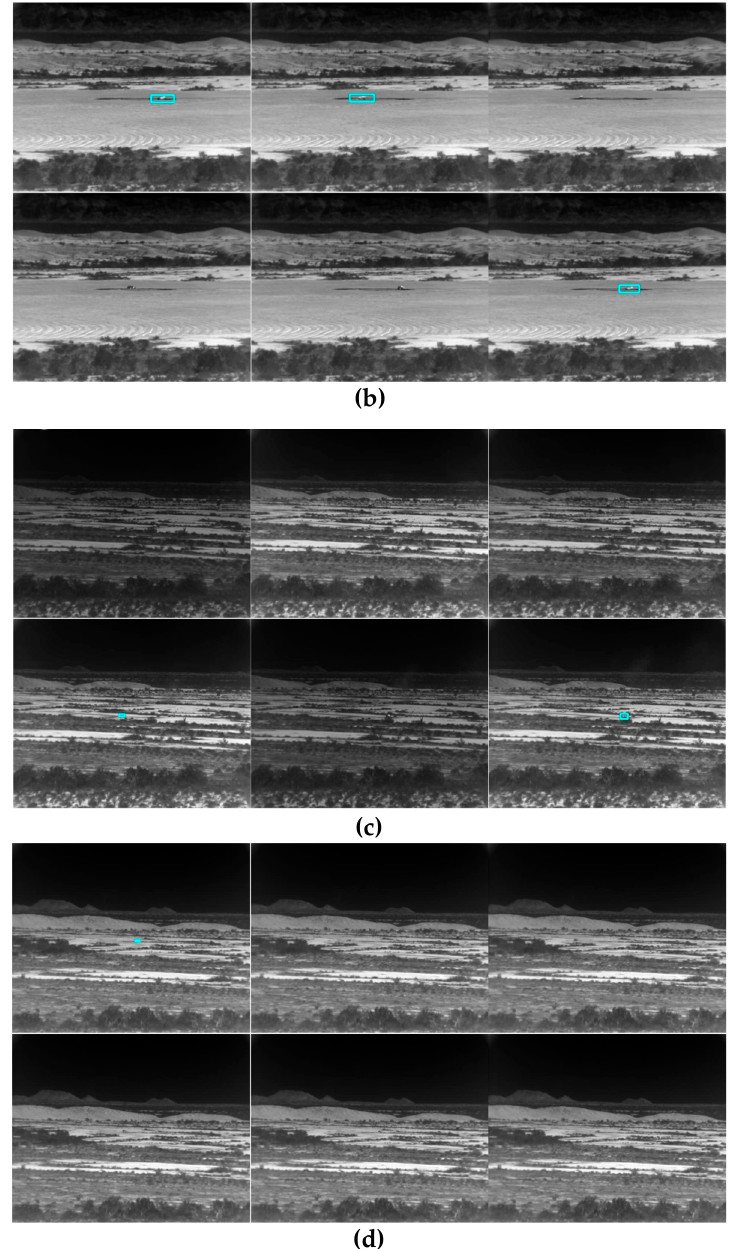
Figure 10. Tracking results for frames 1, 60, 119, 178, 237, and 296 for the PCE full (MWIR daytime) case. The vehicle is SUV. Only some frames have detections. ( a ) 1000 m; ( b ) 2000 m; ( c ) 2500 m; and ( d ) 3500 m.